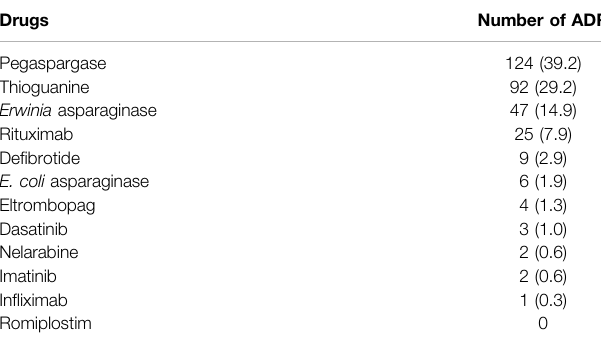
TABLE 3 | Number of ADR with study drugs as